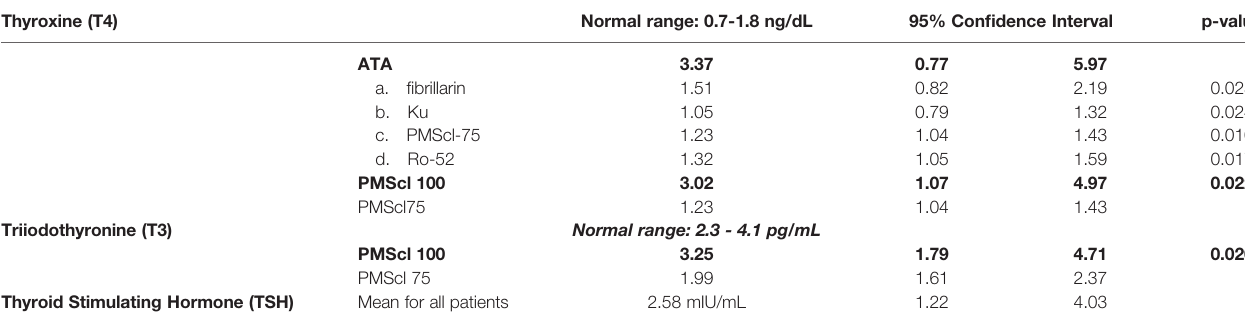
TABLE 6 | Comparison of thyroxine (T3) and triiodothyronine (T4) hormone levels in patients with different types of autoantibodies. Thyroxine (T4) Normal range: 0.7-1.8